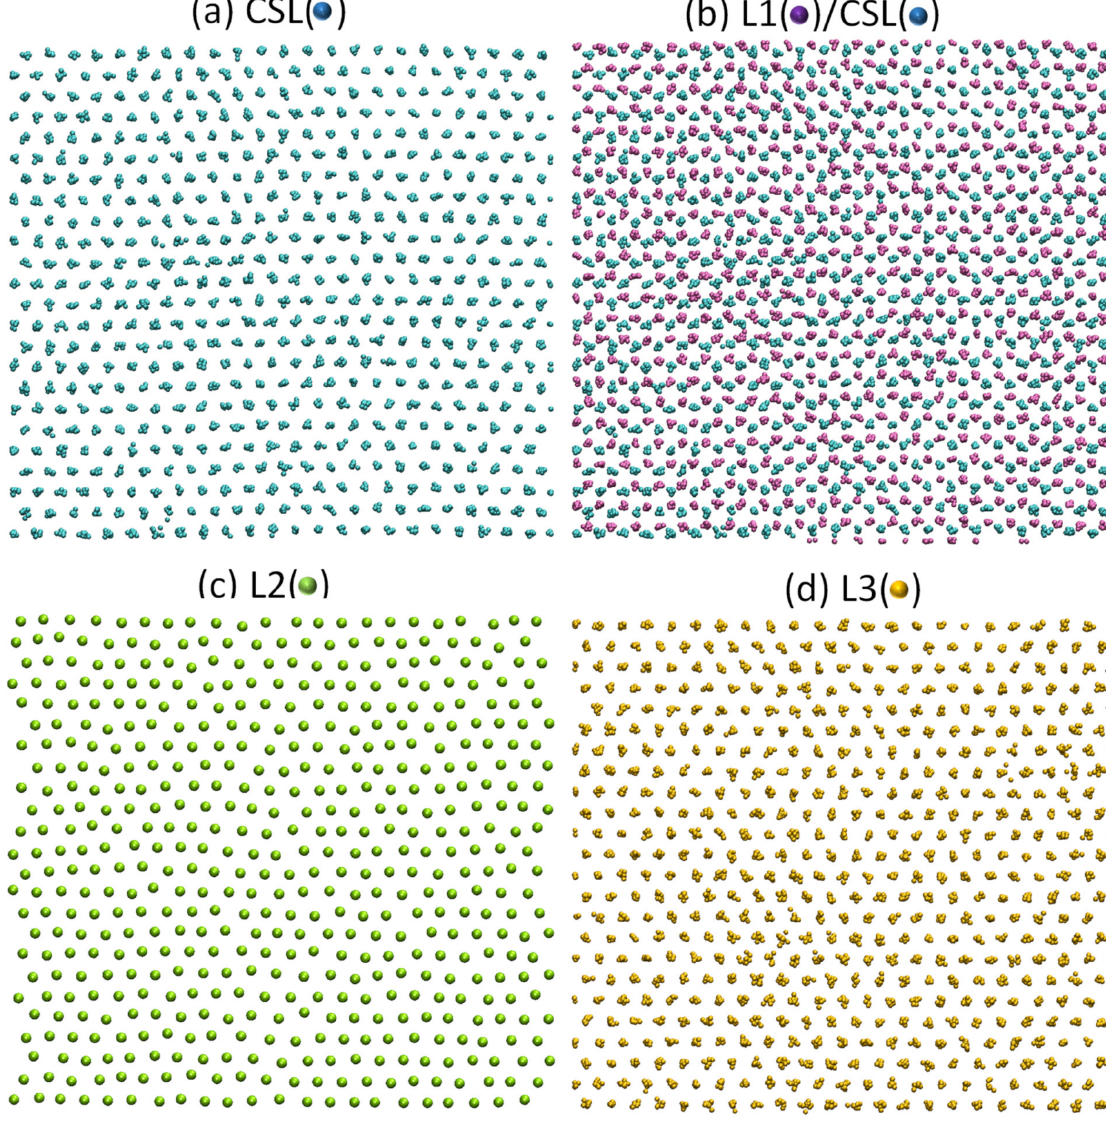
Figure 15. Nucleation mechanism in systems with large misfit [39]. The simulation system: Pb( l )/Cu( s ); T n = 594 K; 27% misfit; t 2 = 190 ps. ( a ) Time-averaged atomic positions in the co- incidence site lattice (CSL, the new substrate) showing CSL as a mechanism to accommodate the major lattice misfit ( f CSL = 25%); ( b ) time-averaged atomic positions in L1/CSL showing the epitaxial relationship between L1 and the CSL; ( c ) a snapshot of L2 showing the existence of vacancies as a mechanism to accommodate the residual lattice misfit ( f r = 2.3%); and ( d ) time-averaged atomic positions of L3 showing a plane of {111} Pb as a 2D nucleus that demarcates the end of nucleation and the start of crystal